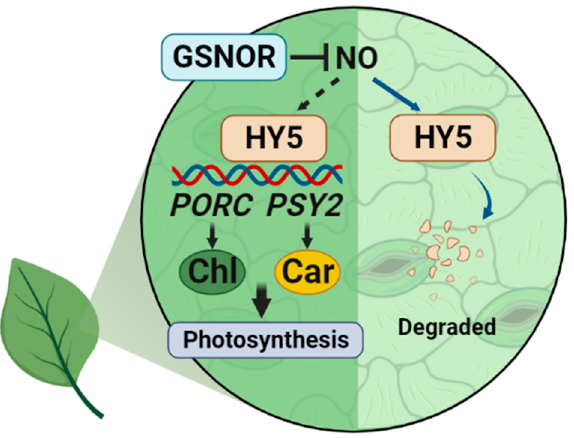
Figure 7. A working model of how NO suppresses HY5-mediated photosynthetic pigment biosynthesis in tomato. Excess NO, which can be eliminated by GSNOR, reduces HY5 stability to inactivate the transcription of pigment biosynthetic genes PORC and PSY2 , thereby suppressing chlorophyll and carotenoid biosynthesis and photosynthesis.